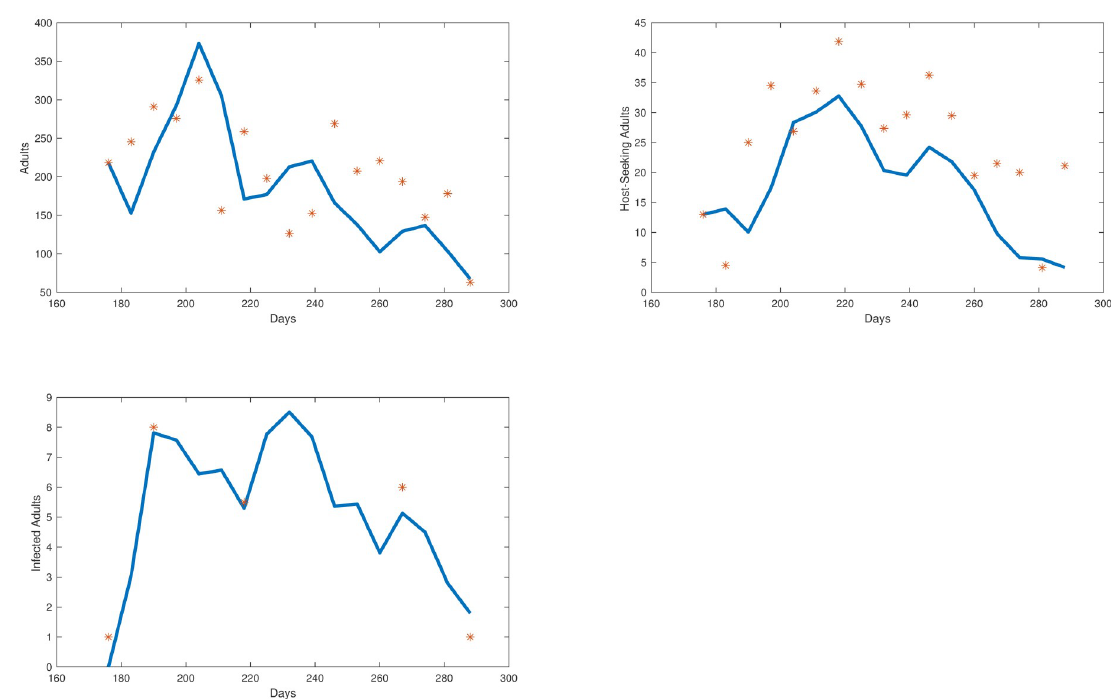
Fig 7. Collected egg, uninfected adult, and infected adult mosquito data (represented by red stars) vs egg, uninfected adult, and infected adult model simulations (represented by the blue line).